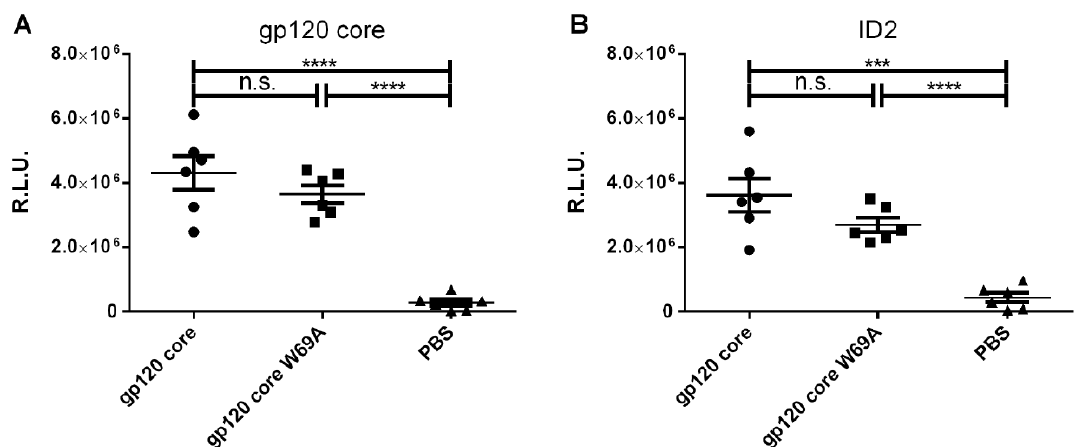
Figure 2. Elicited antibodies recognize the inner domain of gp120. Indirect ELISA on ( A ) gp120 core and ( B ) ID2 using immunized guinea pig sera (1:10 000 dilution). Data shown is the mean of four independent experiments. Error bars represent the standard error of the mean. Differences between groups were compared using unpaired t-test (n.s., not significant; *** p < 0.001; **** p < 0.0001). R.L.U., Relative light units.